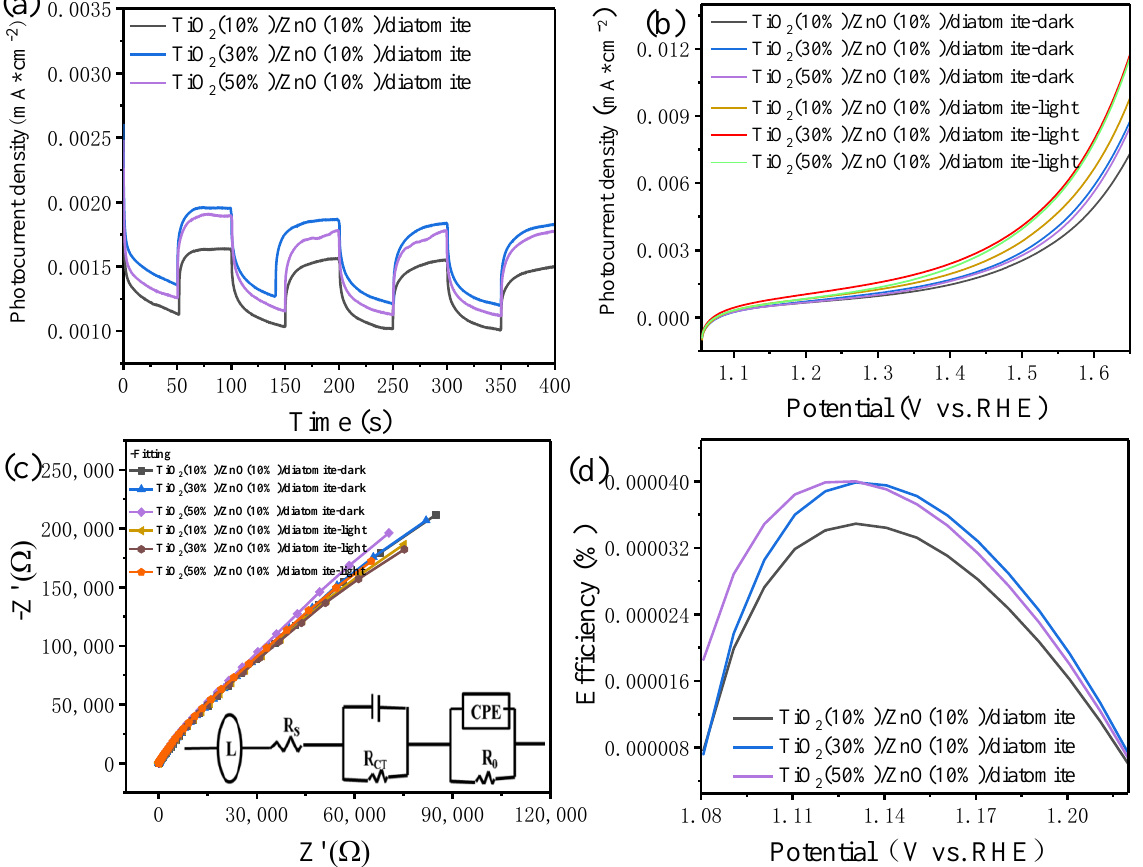
Figure 17. Amperometric I–t curves ( a ), photocurrent densities ( b ), Nyquist plots ( c ), and water splitting efficiencies of TiO 2 (X%)/ZnO(10%)/diatomite ( d Figure 17. ( a ) Amperometric I – t curves, ( b ) photocurrent densities, ( c ) Nyquist plots, and ( d ) water splitting efficiencies of TiO 2 (X%)/ZnO(10%)/diatomite.